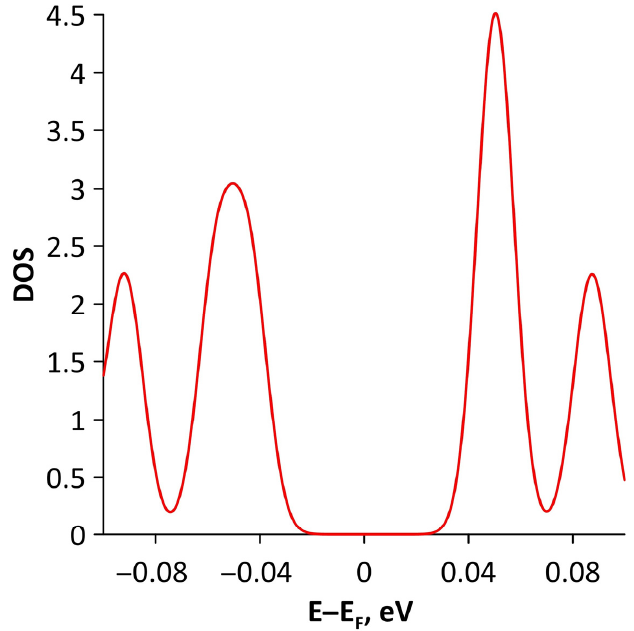
Figure 24. Fragment of DOS near the Fermi level (shifted to 0 eV) of borophene/ZnO heterostructure under biaxial compression by 6%.